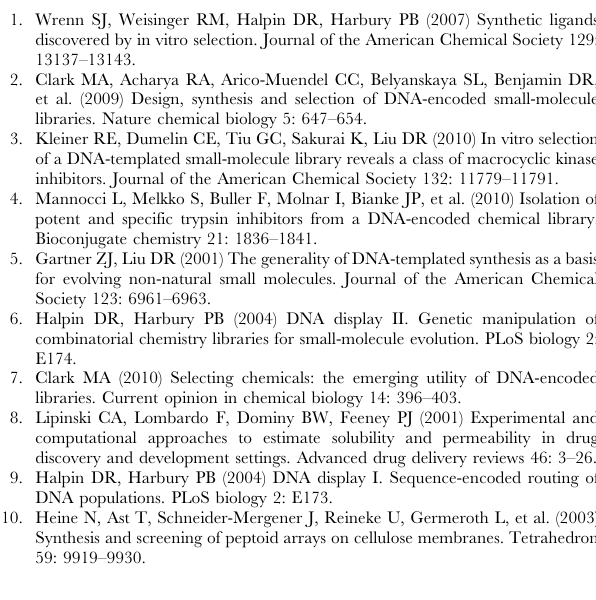
Figure S5 Engineering drawing of bottom plate for chemistry device. Figure S6 Engineering drawing of top plate for chem- istry device. Figure S7 Engineering drawing of internal plate for mesofluidic pump. Figure S8 Engineering drawing of outer plate for mesofluidic pump. Figure S9 Engineering drawing of internal plate for mesofluidic pump. Figure S10 Engineering drawing of outer plate for mesofluidic pump.